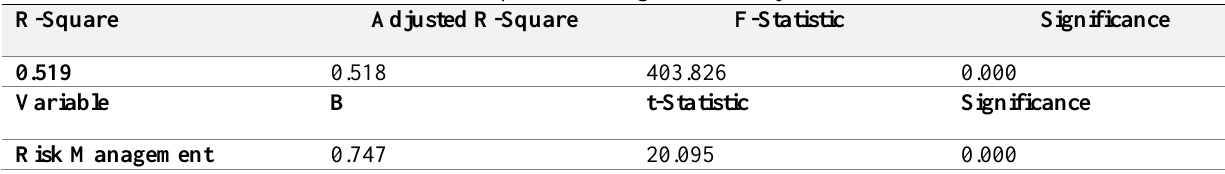
Simple Linear Regression